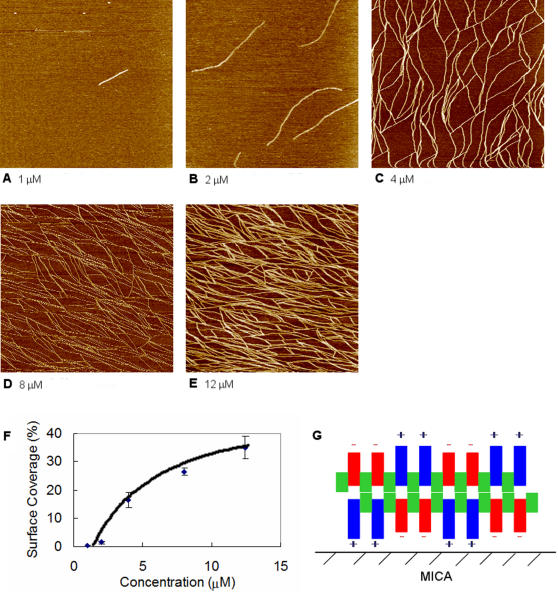
Effect of EAK16-II concentration on the surface coverage of peptide assemblies on mica.AFM images of EAK16-II-modified mica surfaces at 10 min incubation in solutions with various peptide concentrations: (a) 1 µM; (b) 2 µM; (c) 4 µM; (d) 8 µM; (e) 12 µM. Surface coverage of EAK16-II nanofibers on mica as a function of peptide concentration is plotted in panel (f). Proposed molecular arrangement of EAK16-II assembly on mica is plotted in panel (g). Each image corresponds to a scan area of 2000 nm×2000 nm.